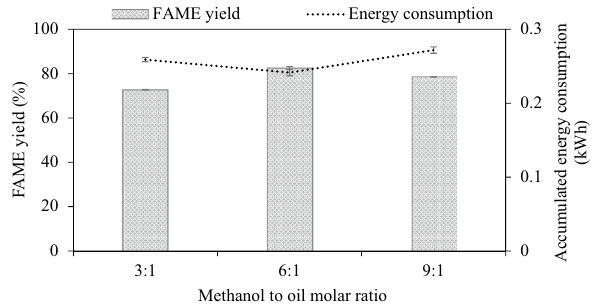
Figure 3. Effect of reactant molar ratio on steady-state FAME yield (refined palm oil, 2000 mL, 50 mL/min, 1 wt% NaOH, 62–63